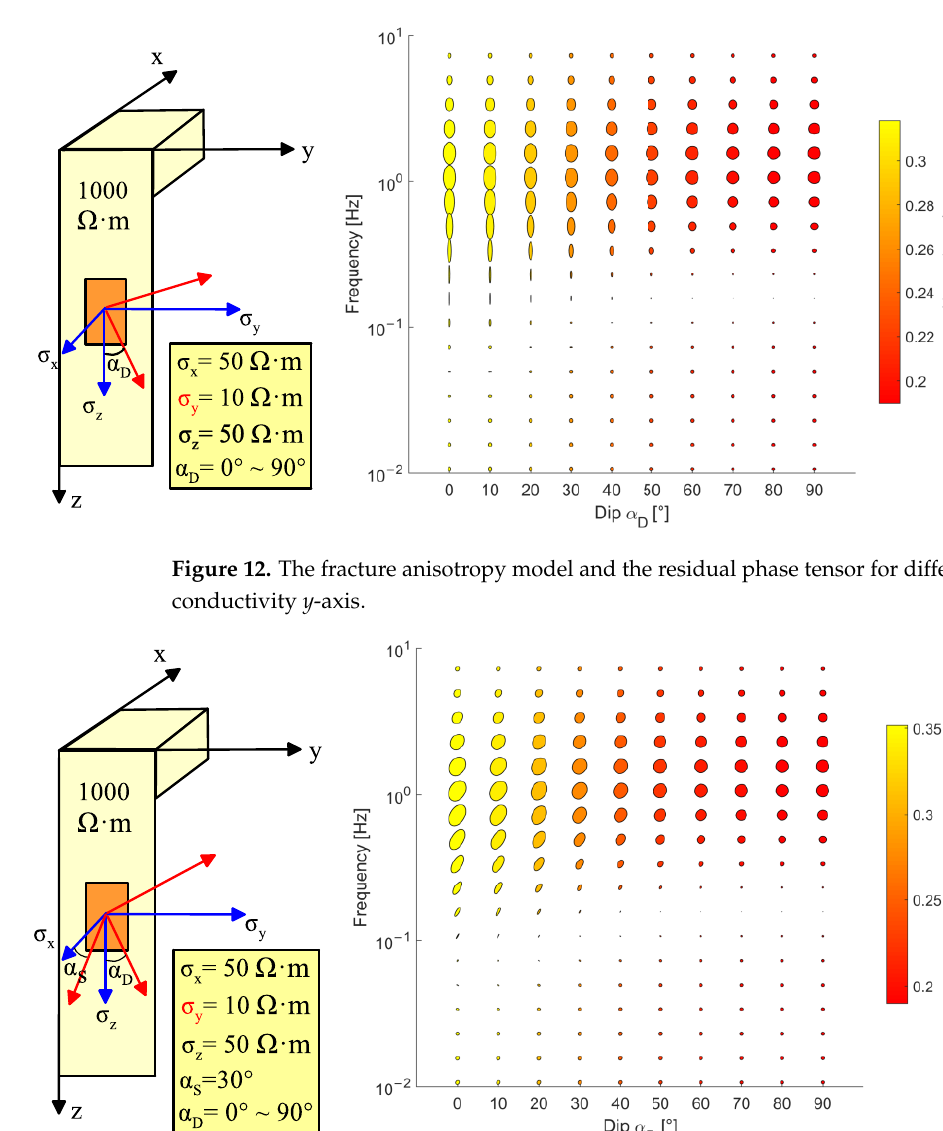
Figure 11. The residual phase tensor for different strike angles of the conductivity y-axis.